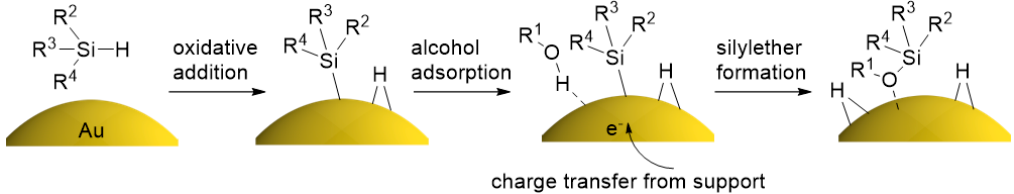
Figure 6. Plausible mechanism of the silane alcoholysis on the AuNP surface accelerated by the charge transfer from support.